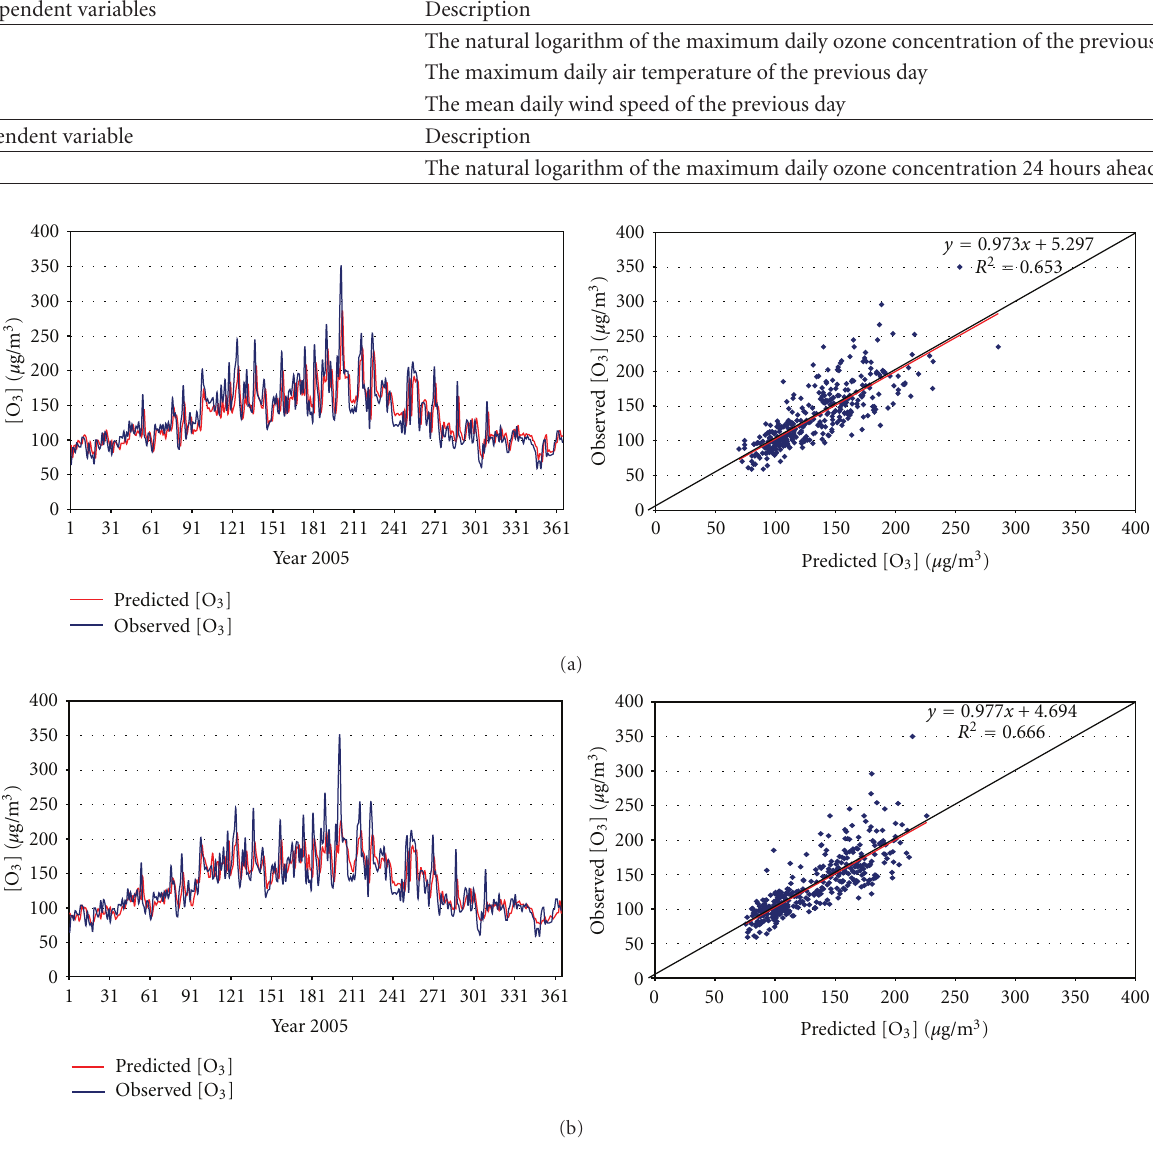
Figure 5: Observed (blue line) and predicted (red line) ozone concentration values 24 hours ahead for MLR (a) and ANN (b) model, year 2005.